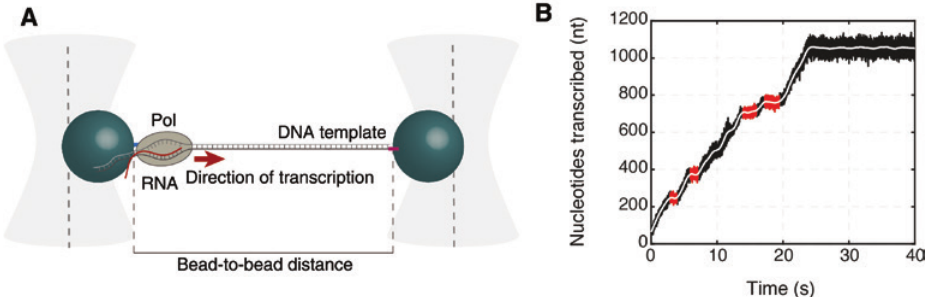
Figure 1: Dual-trap optical tweezers experimental set-up scheme and a representative RNA polymerase trajectory. (A) Two optical traps (grey) are used to trap functionalised polystyrene beads, typically around 2 μ m in diameter (green). Tagged polymerase is attached to one bead and the labelled DNA is attached to another bead. In the opposing force mode experimental set-up shown here, the polymerase transcribes the DNA in between the two beads, therefore shortening the bead-to-bead distance during the experiment, while the forces applied to the enzyme are increased. Note: the scheme is not to scale. (B) Example optical tweezers transcription trace showing transcribed nucleotides over time of an individual transcribing RNA polymerase I. The raw unfiltered data is shown in black, with the filtered trace overlaid in white. Pauses are marked in